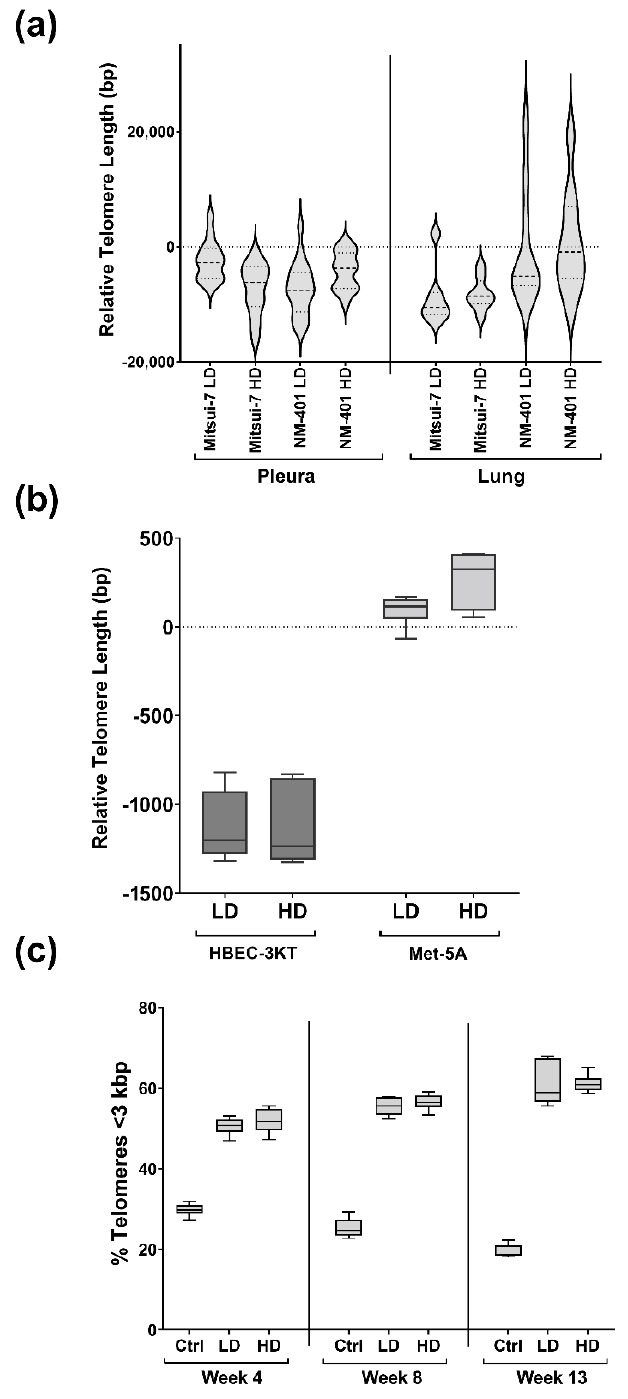
Figure 3. Effects of multiwalled carbon nanotubes (MWCNT)-exposure on telomere length. ( a ) Violin plots with relative telomere lengths in MWCNT Mitsui-7- and NM-401-exposed animals compared to sham animals (pleura: Mitsui-7 LD: n = 15 and HD: n = 14; NM-401 LD: n = 18 and HD n = 17; lung: Mitsui-7 LD: n = 7 and HD: n = 8; NM-401 LD: n = 10 and HD n = 9). ( b ) Box plot with relative telomere length in NM-401-exposed cells. Data indicates mean ± 5 percentiles of telomere length of merged data from all weeks measured ( n = 6). ( c ) Percentage of telomeres in HBEC-3KT cells with a length below 3 kbp was measured after 4, 8, and 13 weeks of exposure to NM-401. Data indicate mean ± 5 percentiles ( n = 2). Low dose (LD), high dose (HD).